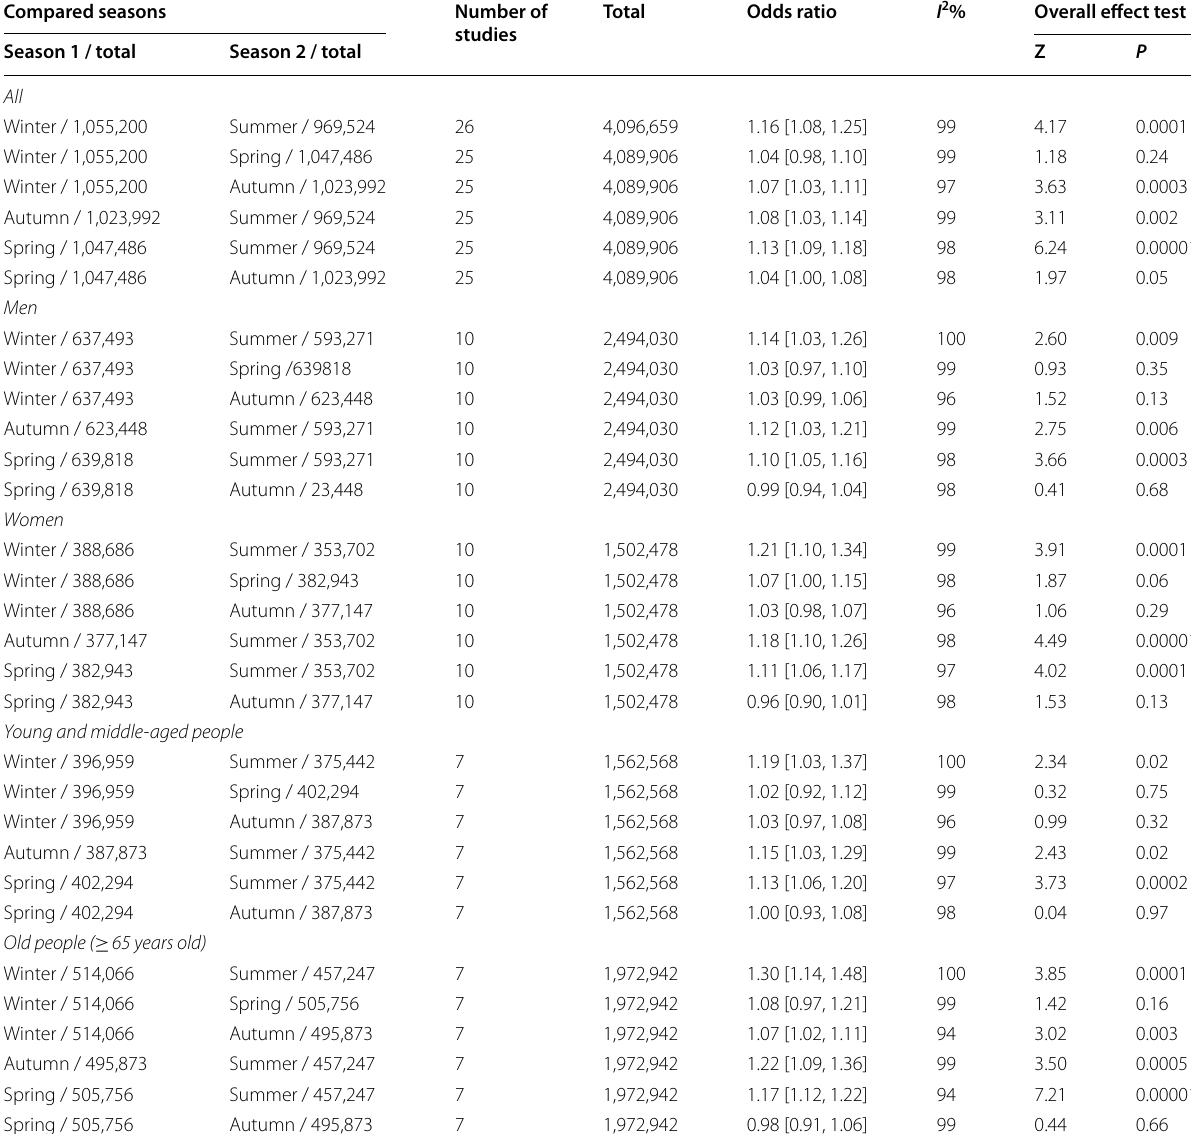
Table 3 Dependence of myocardial infarction risk on the season Compared seasons Number of